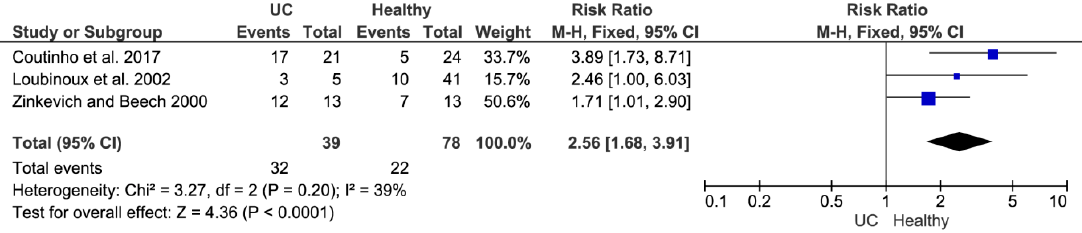
Figure 5. The occurrence of SRB in a group of healthy people and patients with UC .